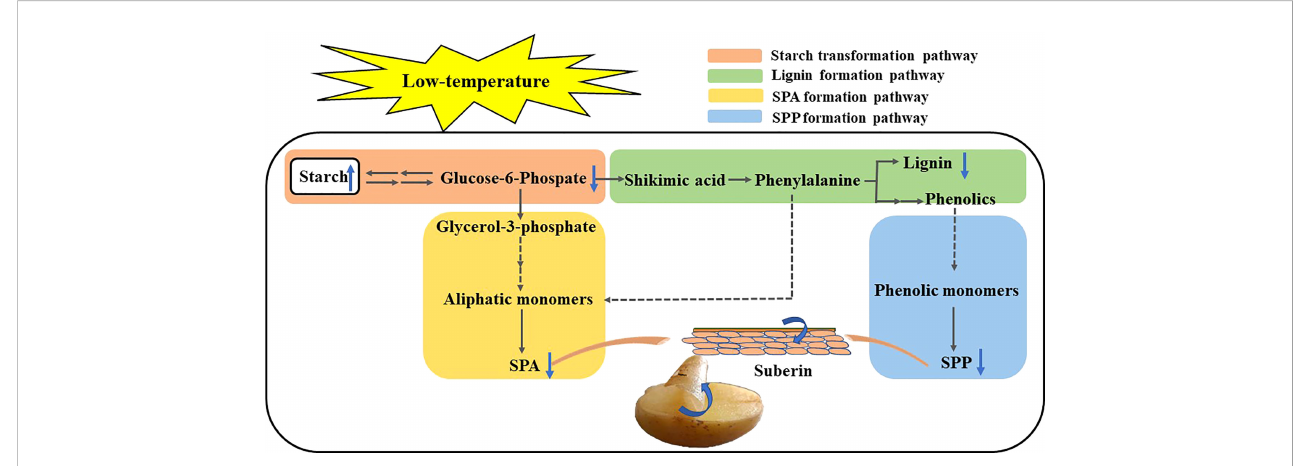
FIGURE 5 Pattern of metabolic pathways involved in potato wound